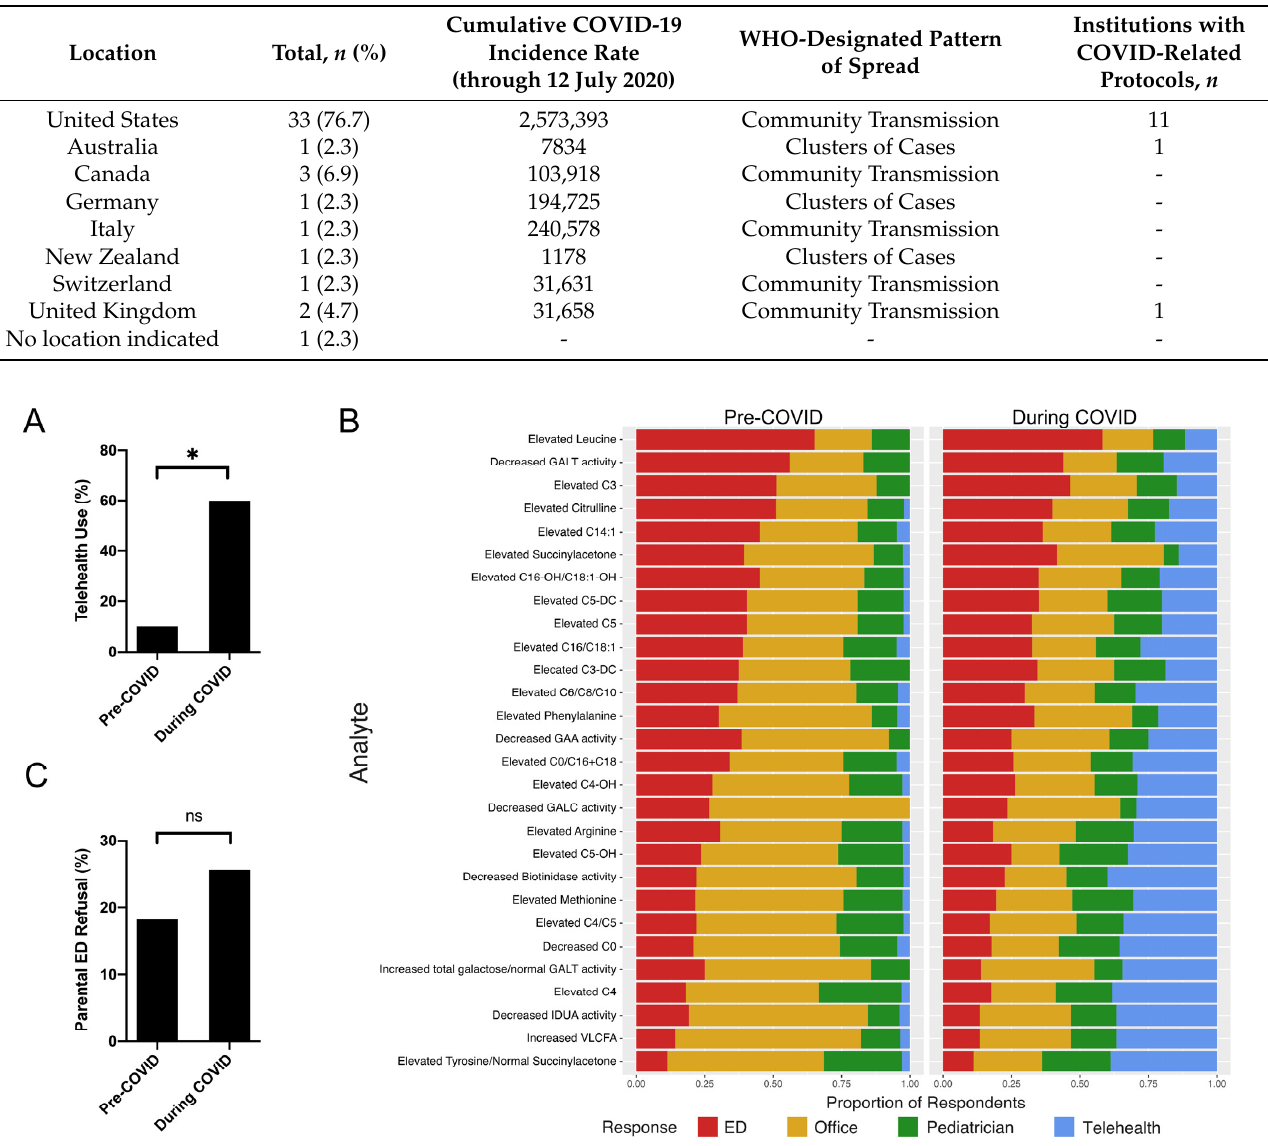
Table 1. Respondent demographics.